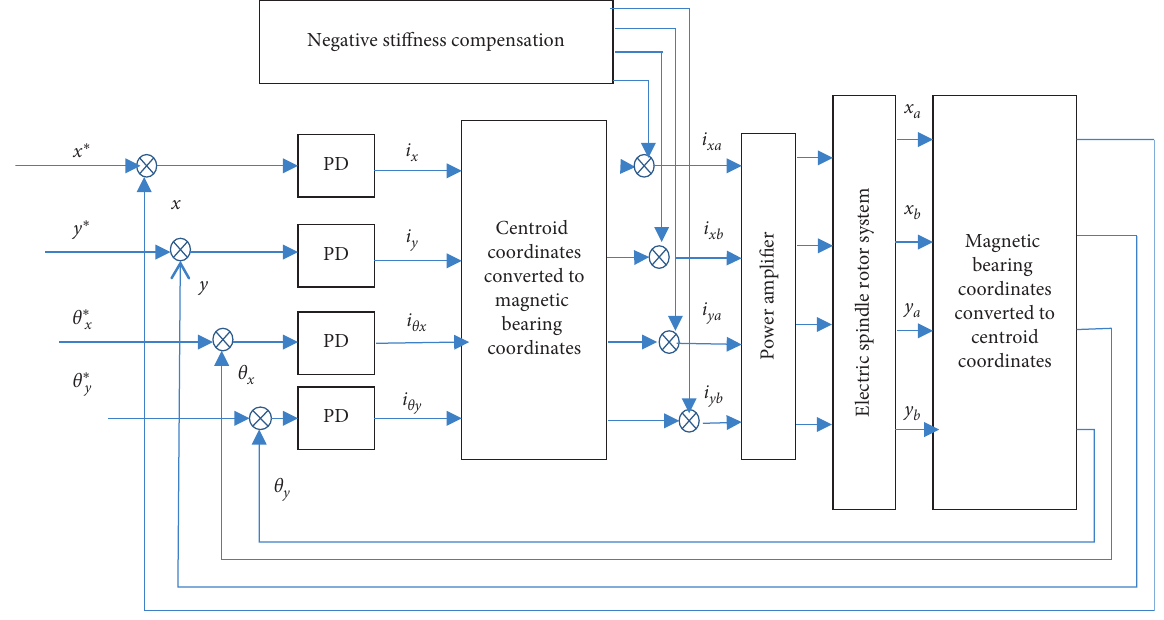
Figure 2: Modal decoupling control system.